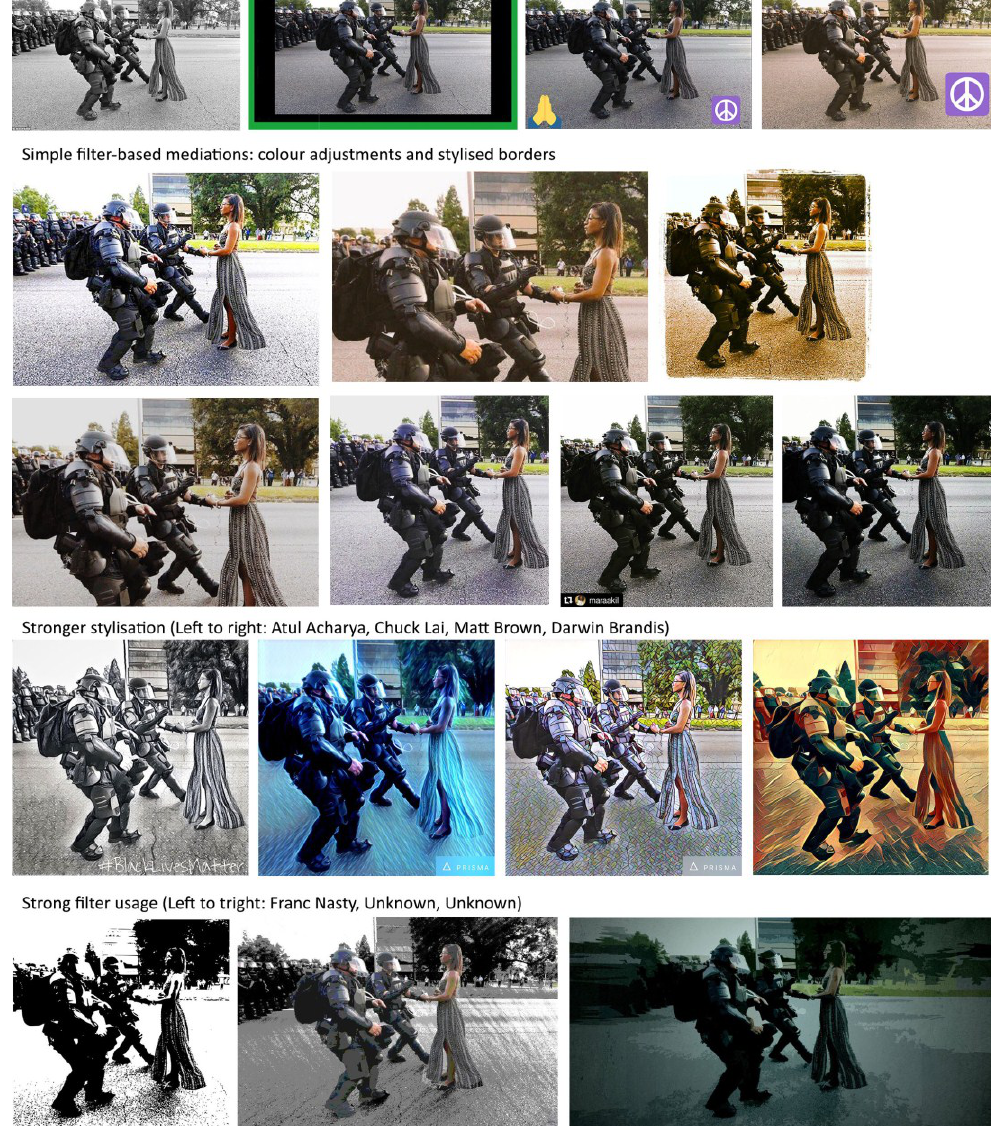
Figure 6. Filter-based mediations. Source: Twitter.